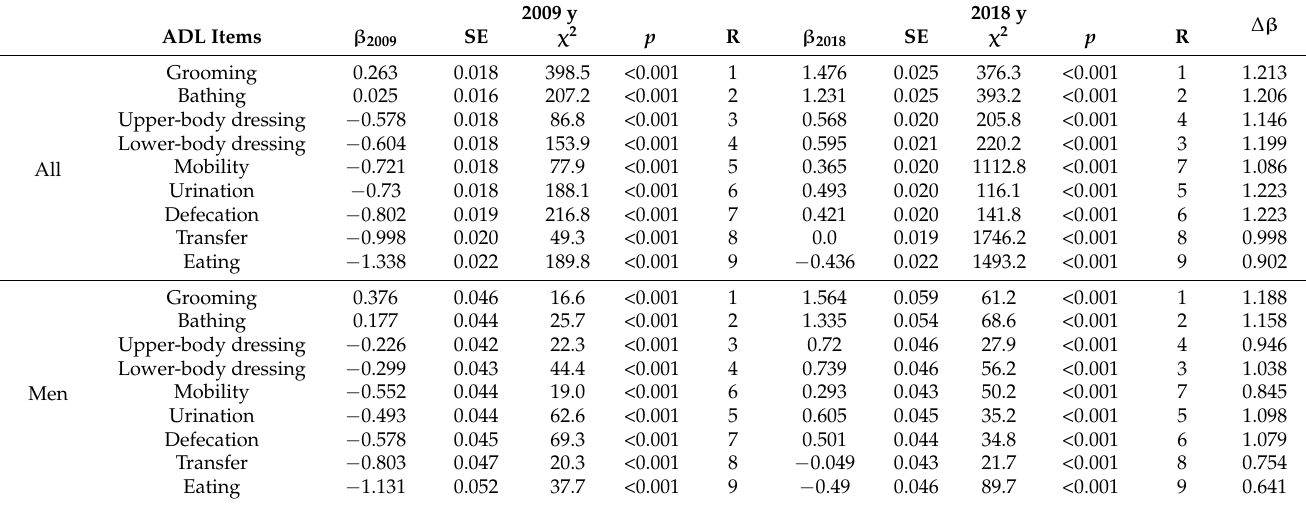
Table 3. Proportion of positive responses for each ADL item in both 2009 and